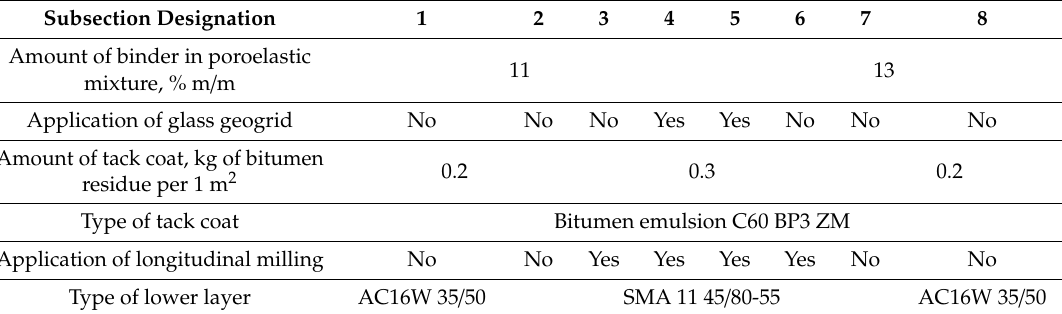
Table 3. Summary of construction variants for the Galaktyczna trial section.